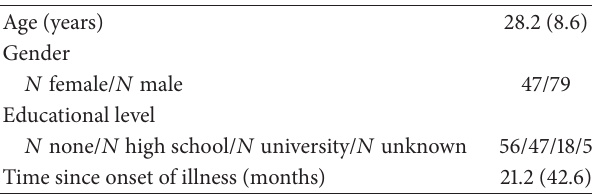
Table 1: Demographics of the initial sample ( 𝑁 = 126 ), results represented by mean value and standard deviation or absolute